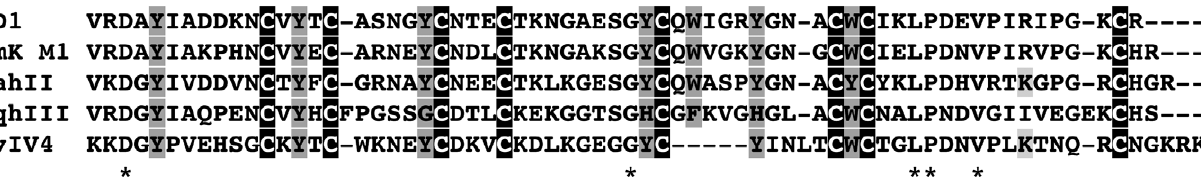
Figure 9. Comparison of CvIV4 with Old World a -toxins that modulate Na v 1.7. CvIV4 is aligned with ODI, BmK MI, AahII and LqhIII, Old World a -toxins that slow the fast inactivation of Na v 1.7. The biological activity of CvIV4 is similar to these peptides, but its primary structure is not. Gaps were introduced to align cysteine residues (white font with black background). Hydrophobic residues (dark shaded background) that are critical for a -toxin structure and function are conserved in CvIV4 at positions 5, 14, 22, 36, 43 and 49 [28]. CvIV4 shares a lysine (light shaded background) with AahII (position 60) that is critical for the biological activity of AahII [29]. Additional amino acids that are identical among toxins are marked with an asterisk (*). GenBank accession numbers: CvIV4 (JF938594), ODI (P84646), BmK MI (P45697), AahII (P01484), LqhII (P59355). MAFFT version 6 used for sequence alignment (http://mafft.cbrc.jp/alignment/software/).